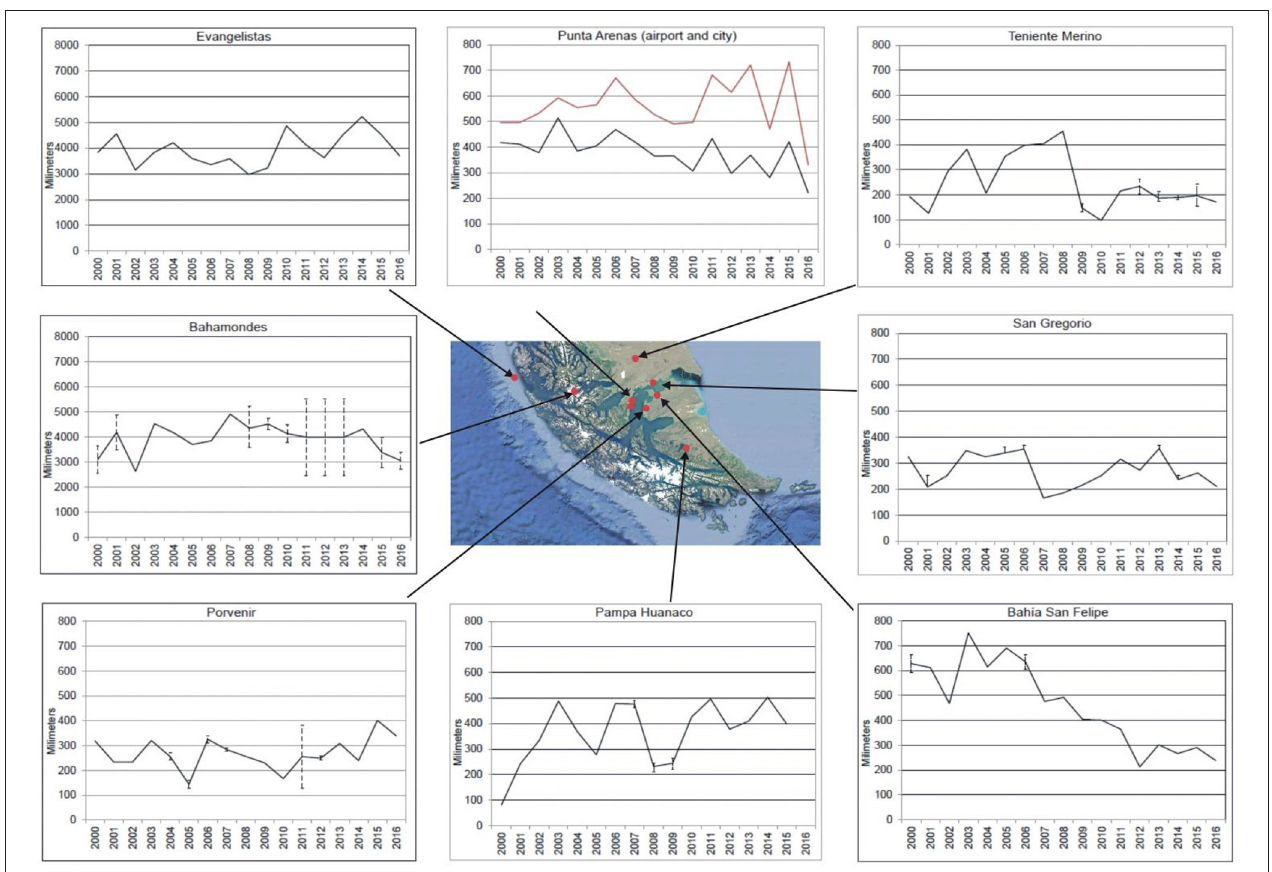
FIGURE 4 | Annual precipitation time series for the 2000–2016 period. Vertical lines in some graphs are the sum of the 1st standard deviation of the missing months, which were replaced by their respective monthly averages. Note that the vertical range at Evangelistas and Bahamondes stations (the two western locations) is 8,000mm, while all other stations have a range of